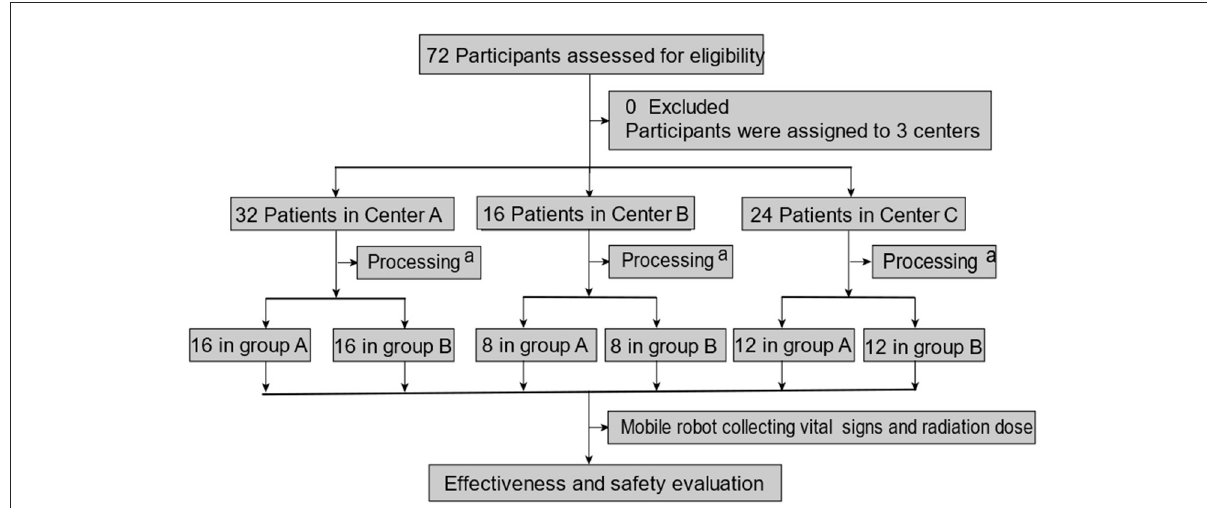
FIGURE2 Patient enrollment and test assignment. a processing includes participants being divided into two groups, and then, they were treated with 131I. A mobile robot collecting vital signs and radiation dose rate was performed in the morning or afternoon on the second day after being treated with 131I (within 15–24h). Vital signs include temperature and blood